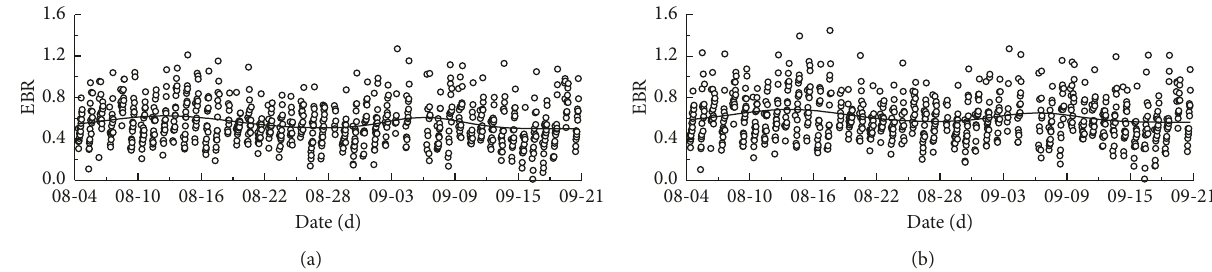
Figure 11: EBR variation trends during the entire observation period: (a) without S and (b) with S